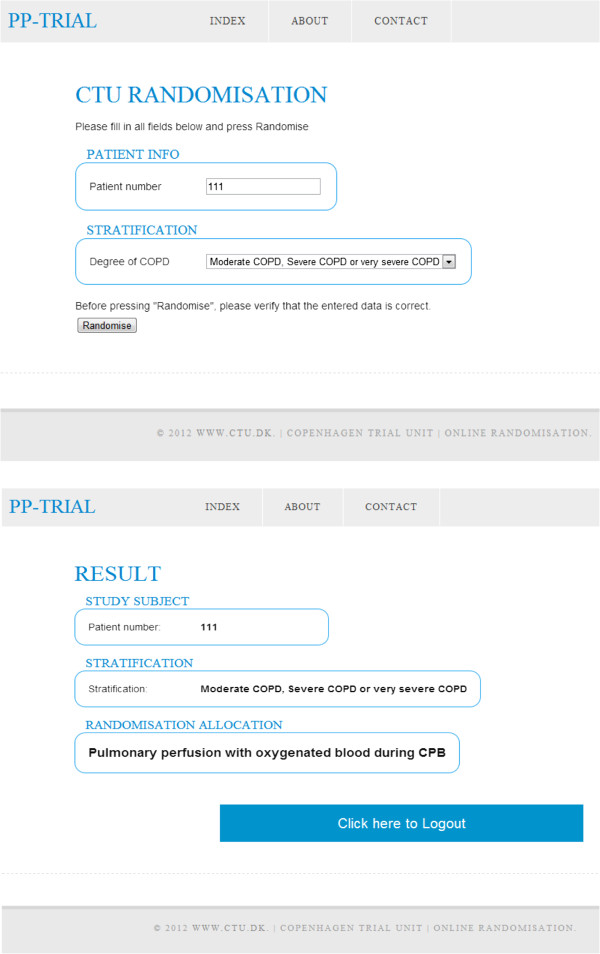
Randomization. Step 1 and 2 in randomization of a patient to intervention with, in this example, pulmonary perfusion with oxygenated blood during CPB generated by a web-based system following successful screening and stratification of a patient (all inclusion criteria fulfilled, no exclusion criteria fulfilled, informed consent obtained). CPB, cardiopulmonary bypass.